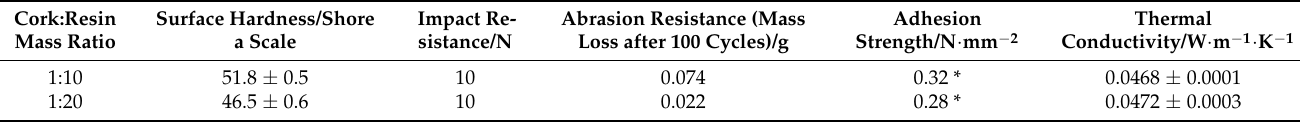
Table 4. Coating characterization